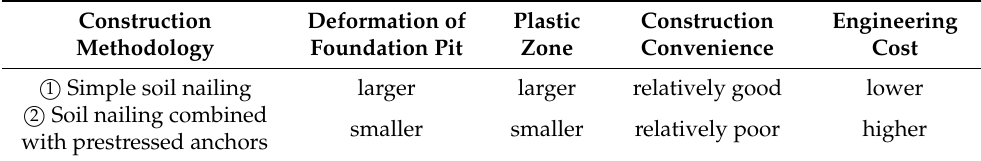
Table 1. The differences in the two building-construction